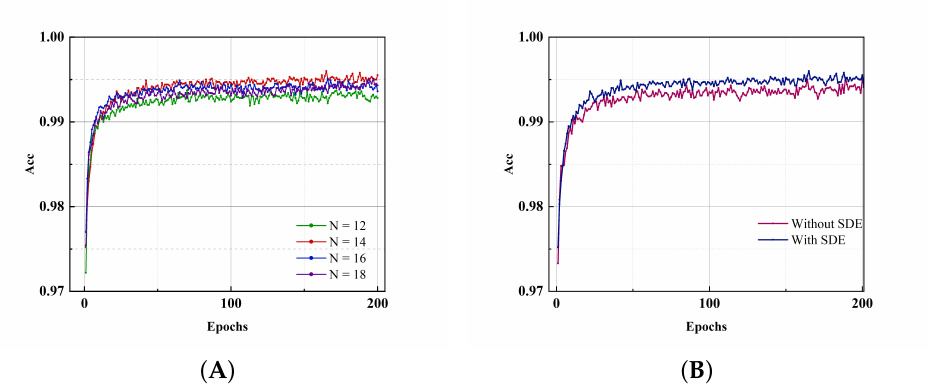
Figure 6. Training curves for different encoding numbers and types. ( A ) The effect of different encoding numbers on network training and performance. ( B ) The effect of different encoding methods.